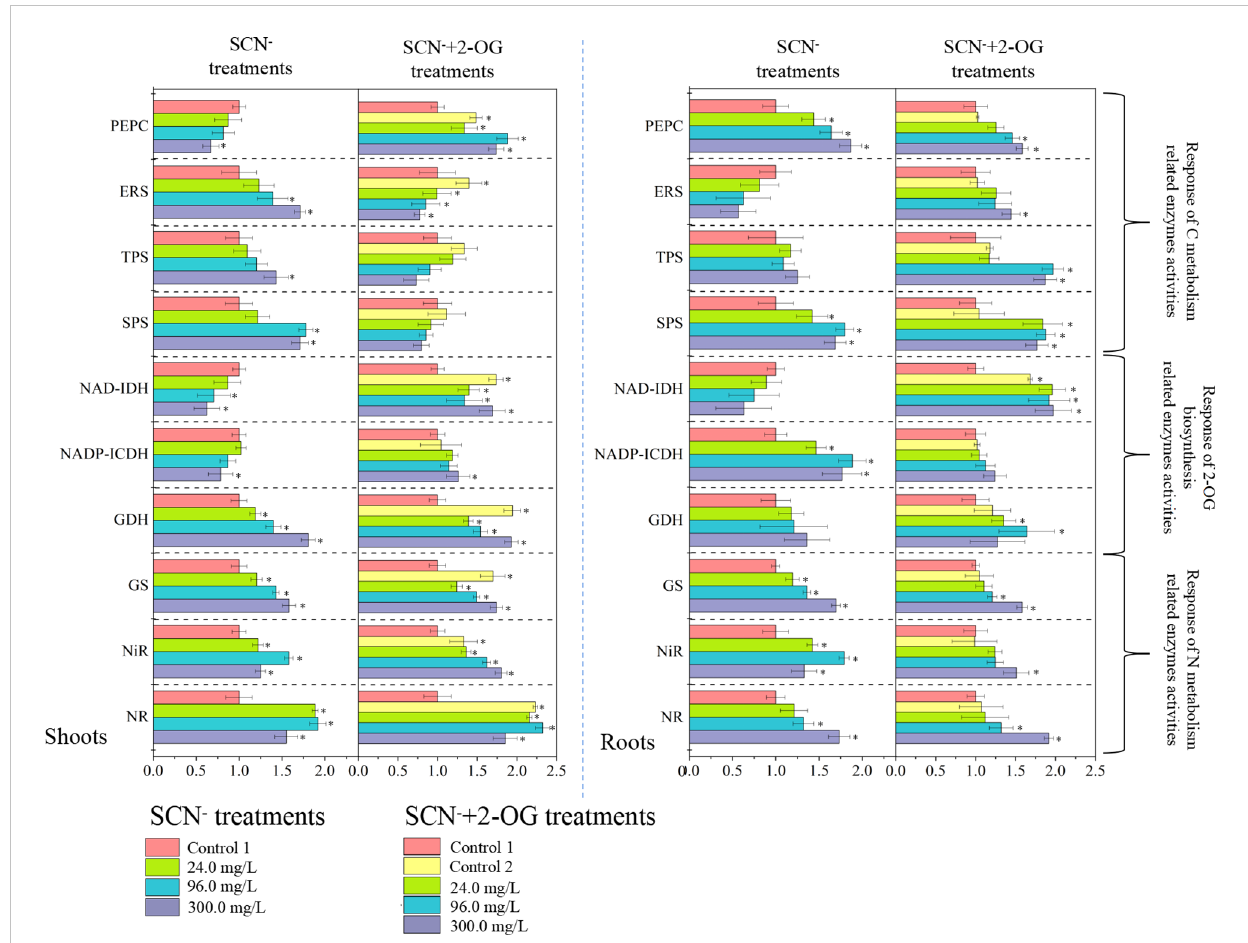
FIGURE 3 Response of CNM-related enzyme activities in rice roots and shoots under SCN − stress in the presence or absence of 2-OG. The asterisk symbol refers to the signi fi cant difference between SCN − -treated (24.0, 96.0, and 300.0 mg SCN/L) and SCN − +2-OG-treated (0, 24.0, 96.0, and 300.0 mg SCN/L) seedlings and control 1 ( p < 0.05). CNM, carbon and nitrogen metabolism; 2-OG,